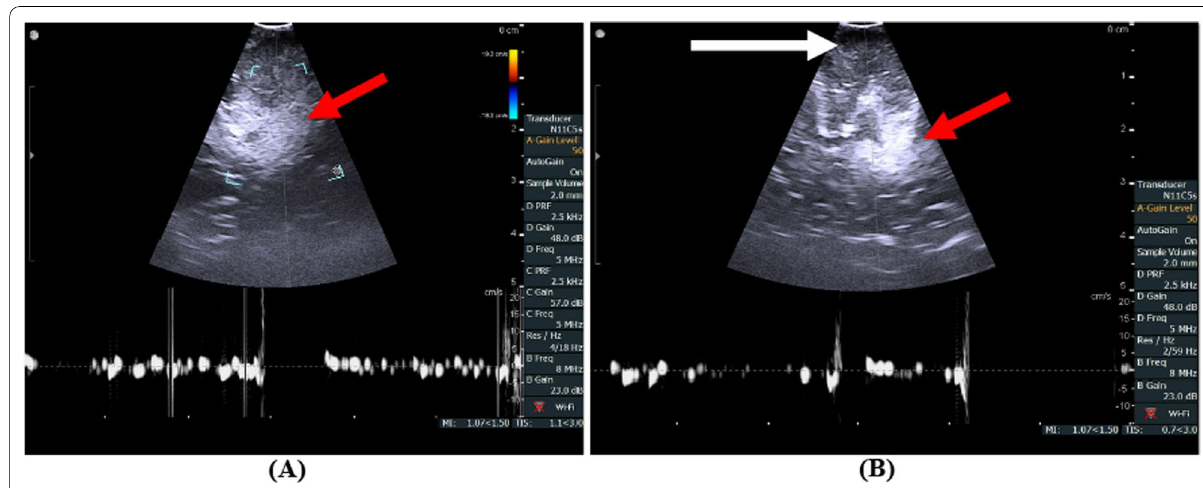
Fig. 12 IOUS of cavernoma case. A The cavernoma appears as hyperechoic lesion (red arrow). B During excision of the cavernoma (hyperechoic shadow) (red arrow). The corridor of excision appears hypoechoic (saline bath) (white